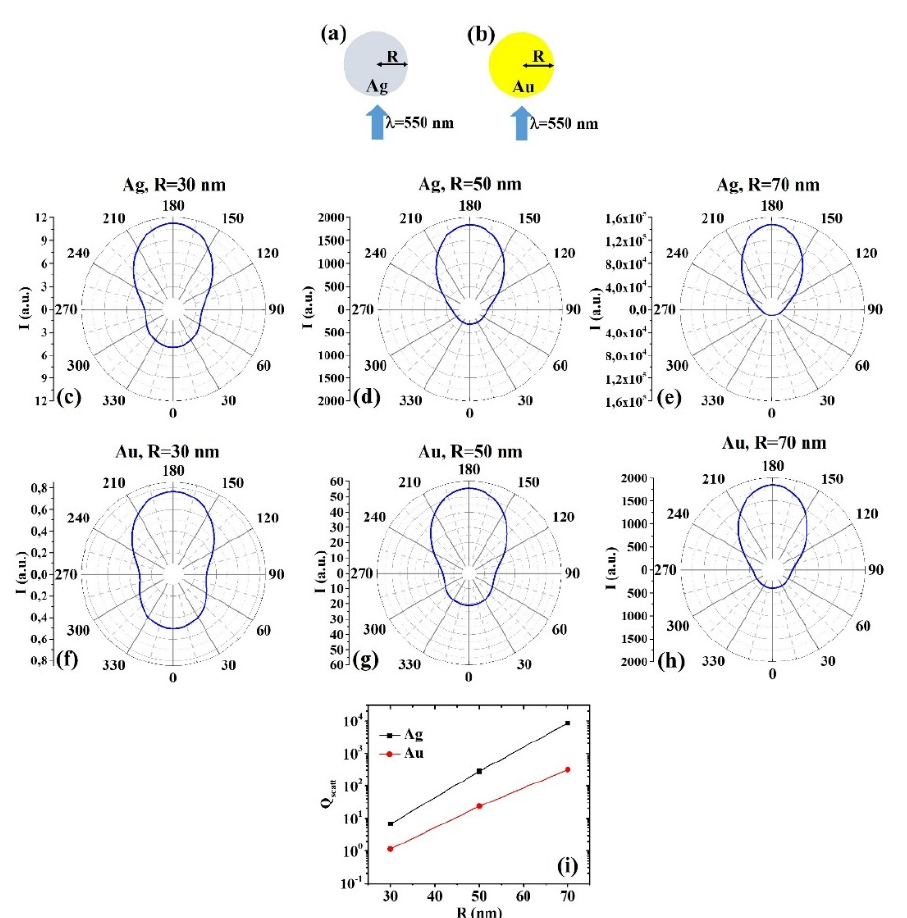
Figure 1. ( a , b ) Scheme of the structure of the simulated Ag ( a ) and Au ( b ) pure spherical particle with radius R and electromagnetic radiation of wavelength λ = 550 nm impinging on the particle from 0°. ( c – e ) Calculated polar diagrams for the intensity of the scattered light from the Ag spherical particle changing the radius R from 30 nm to 70 nm. ( f – h ) Calculated polar diagrams for the intensity of the scattered light from the Au spherical particle changing the radius R from 30 nm to 70 nm. ( i ) Calculated scattering efficiency for the light (wavelength λ = 550 nm) scattering process of the Ag (black dots) and Au (red dots) spherical particle increasing the particle radius from 30 nm to 70 nm. ( 2) Ag/AZO and Au/AZO: (a) R = 30 nm: Figure 2a, b reports the scheme of the structure of the simulated Ag/AZO (Figure 2a) and Au/AZO (Figure 2b) core–shell spherical particle with core ra- dius R and shell width d and electromagnetic radiation of wavelength λ = 550 nm imping- ing on the particle from 0°; in Figure 2c-e the calculated polar diagrams for the intensity of the scattered light from the Ag/AZO core–shell spherical particle fixing the Ag core radius R to 30 nm and increasing the AZO shell width from 10 nm to 50 nm are reported;